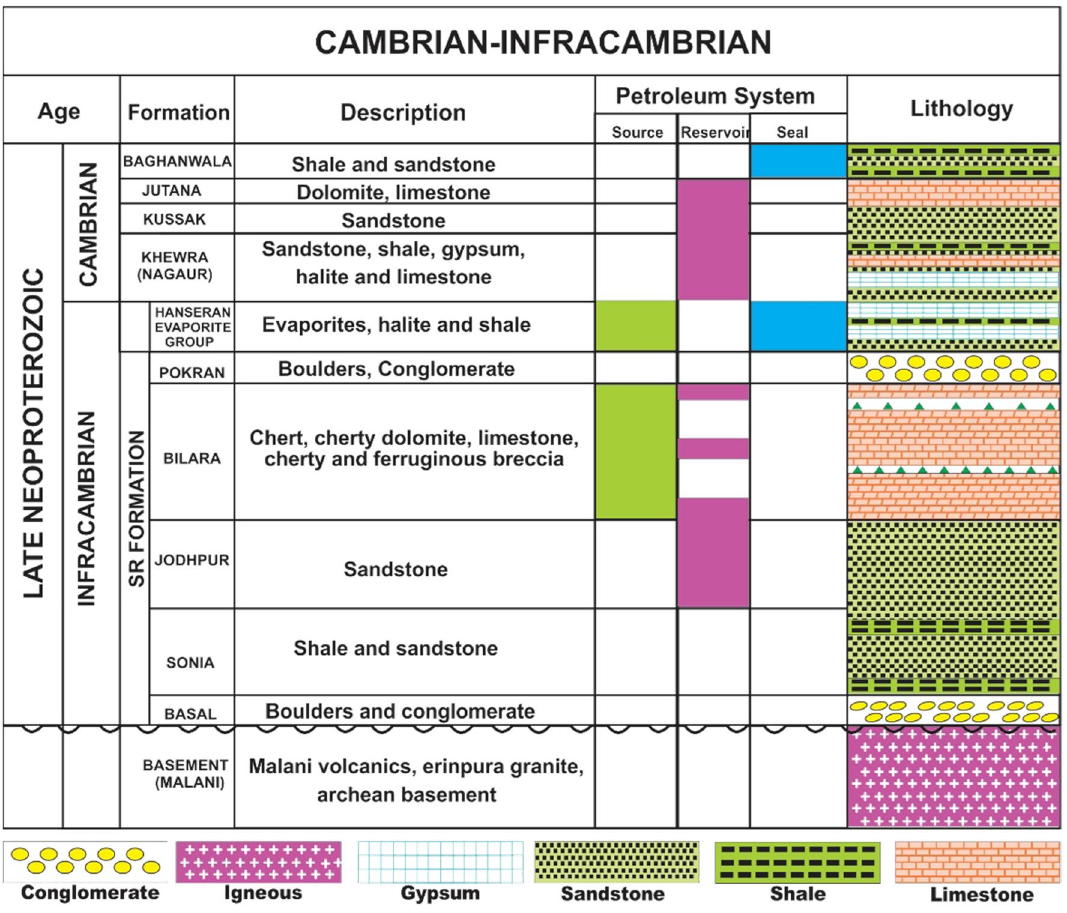
Figure 2. Stratigraphic column and petroleum system of the Cambrian–Infracambrian Salt Range Formation in the SE Pakistan Bikaner–Nagaur Basin 10 .